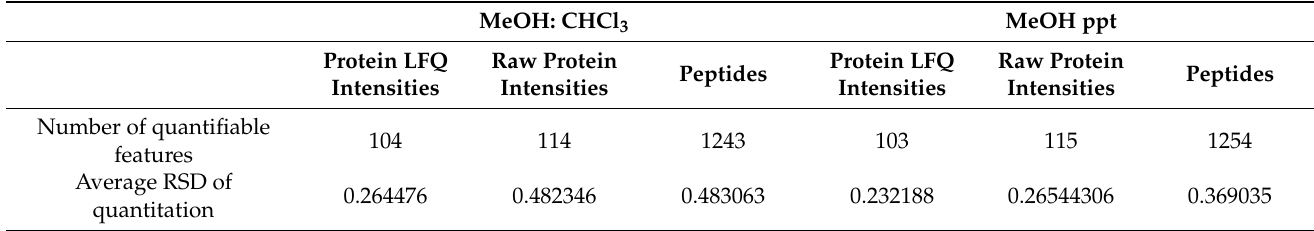
Table 2. Comparing numbers of identified proteins and their average